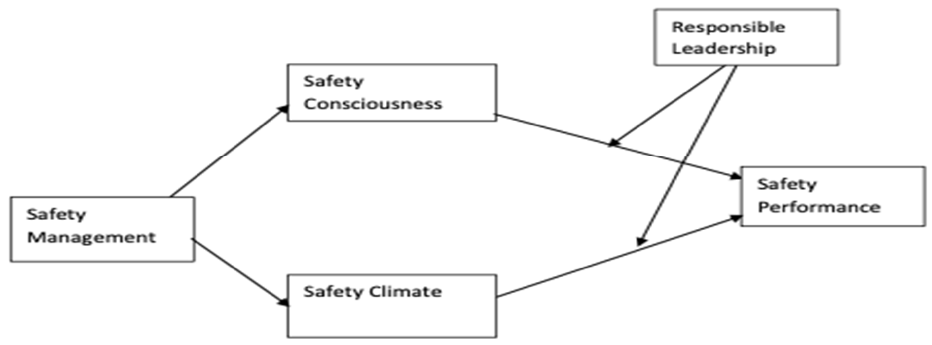
Figure 1. Proposed Research Framework.